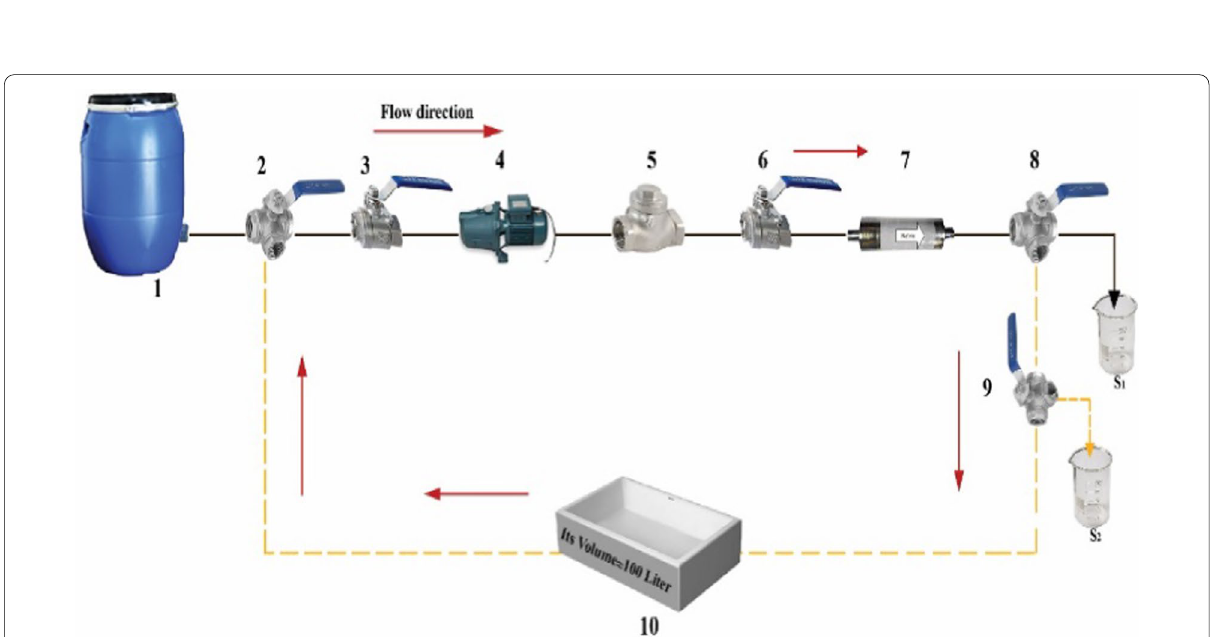
Fig. 4 The schematic diagram of permanent magnetic field PMT system. Where (1) Tank: contains a quantity of brackish groundwater that was supplied here for this experiment. (2) Three‑way ball valve shuts off the water flow in one direction and opens it in another direction. (3) Gate valve (ball valve, 2 ports): normally open. (4) Centrifugal pump. (5) Check valve (swing check valve, 1 inch): non‑return valve used to protect the pump from backflow. (6) Gate valve (ball valve, 2 ports): throttling the flow rate. (7) PWT device: used for treating brackish groundwater (salt content up to 3000 ppm 500). (8) Three‑way valve. (9) Three‑way valve. (10) ±